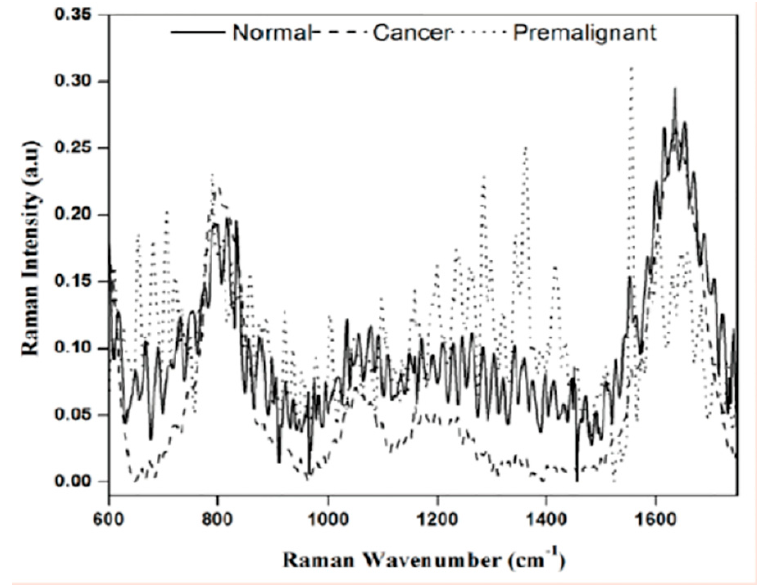
Figure 4. Raman spectroscopic intensity variations and peak shift among saliva samples from three groups [85].